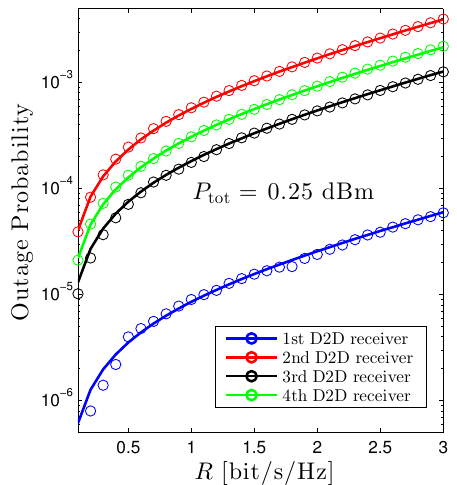
Figure 2. Outage probability of D2D receiver vs. R under the equal power allocation scheme. Solid lines are plotted by employing (12) and markers are Monte Carlo